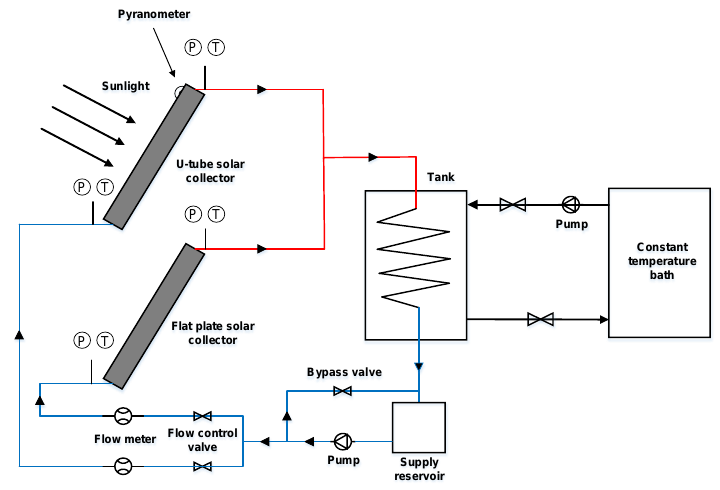
Figure 1. Configuration of experimental apparatus. Table 1. Uncertainties in the measuring equipment.